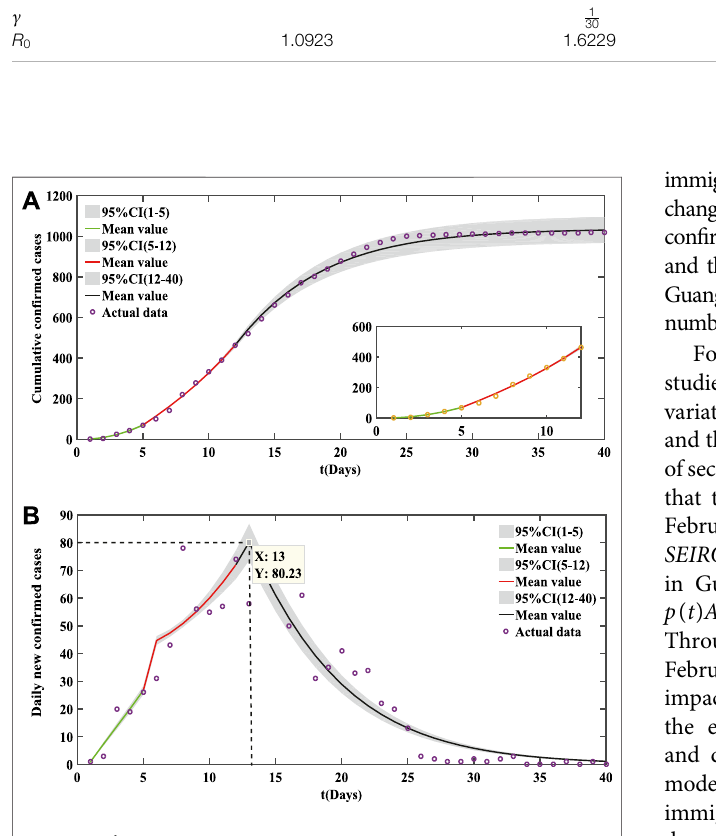
FIGURE 5 | Fitting results of cumulative COVID-19 cases in Hunan Province. (A) Cumulative con fi rmed cases. (B) Daily new con fi rmed cases. Initial value of parameter: S (0) (cid:2) 6.91838 × 10 7 [29], E ( 0 ) (cid:2) 110 , I ( 0 ) (cid:2) 21 , Q ( 0 ) (cid:2) 1 , R ( 0 ) (cid:2) 0.